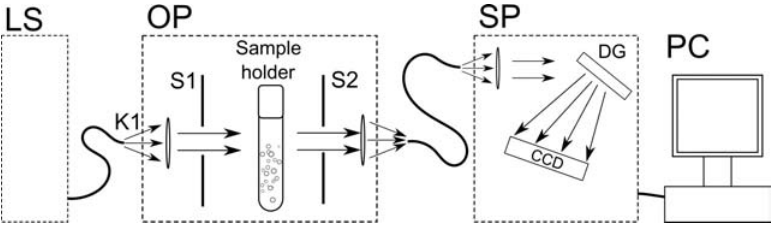
Fig. 3. Absorption spectroscopy laboratory setup (LS — broadband light source, OP — optical probe, SP — spectrometer, K1 — collimator, S1, S2 — slits, DG — di®raction grating).